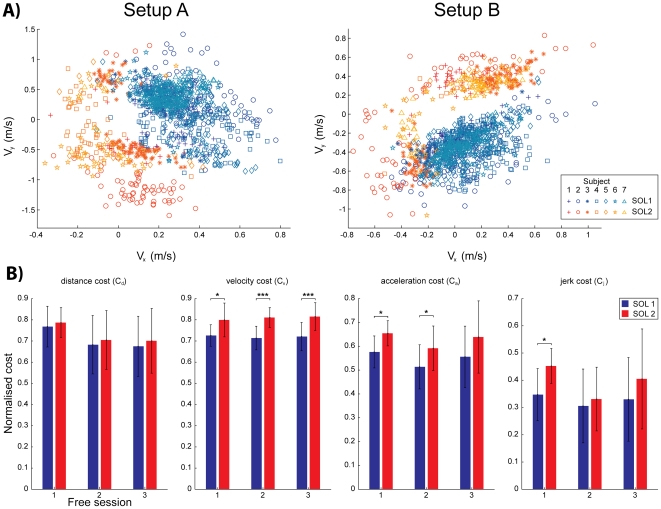
Quantifying the solution differences.A) To quantify the difference between the two subjects solutions, the x and y velocities of the hand were plotted from each trial of every subject (different markers) at their hand position closest to the second via point during execution of SOL1 (blue shades) and SOL2 (red shades). The velocity distribution was confirmed to be different (p<0.001, two-way ANOVA) for each subject. B) The execution costs calculated in terms of distance, velocity, acceleration and jerk were in mean systematically larger in SOL2 than in SOL1, however only the velocity cost was significantly higher. The error bars indicate standard error across subjects.